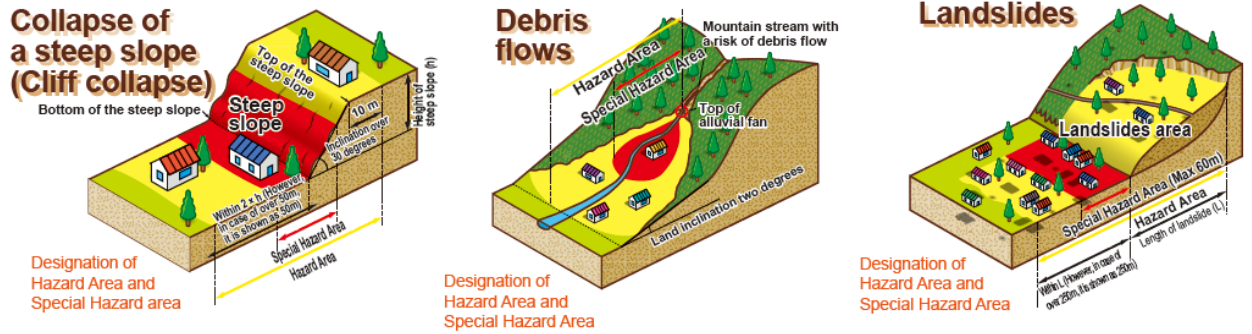
Figure 7. Designation of warning areas for different types of disaster. Areas in red are the sediment disaster special hazard areas; areas in yellow are the sediment disaster hazard areas; and areas in green are the safe areas [48].